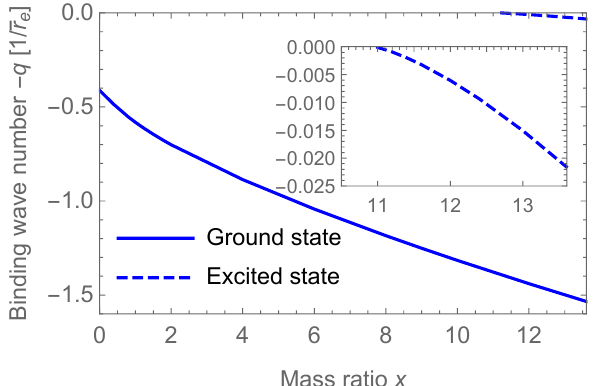
Figure 4: Trimer spectrum in the presence of a p-wave interaction between the fermions, at the doubly resonant limit 1 / a → 0 and 1 / v → 0, and as a function of the mass ratio x between the fermions and the third particle. Here, the p-wave interaction is set to the Gaussian model of Table 2 of Appendix 1, with 1 / ¯ α = ¯ r